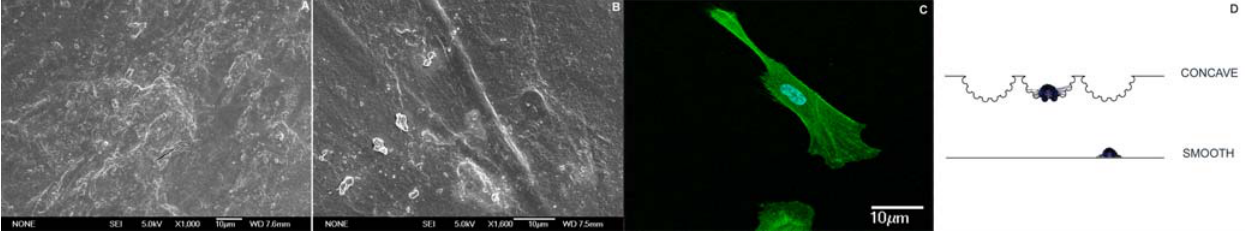
Figure 2. Images showing the results obtained when cells were cultured on the smooth surface. ( A ) smooth surface at SEM (Calibration Bar=10 m m); ( B ) cells, cultured on a smooth surface, under SEM, show an elongated shape (Calibration Bar=10 m m); ( C ) confocal image showing the relationship between cells and the smooth surface (Calibration Bar=10 m m); ( D ) image showing the relationship between cells and the different surface texturing: (1) concave and (2)